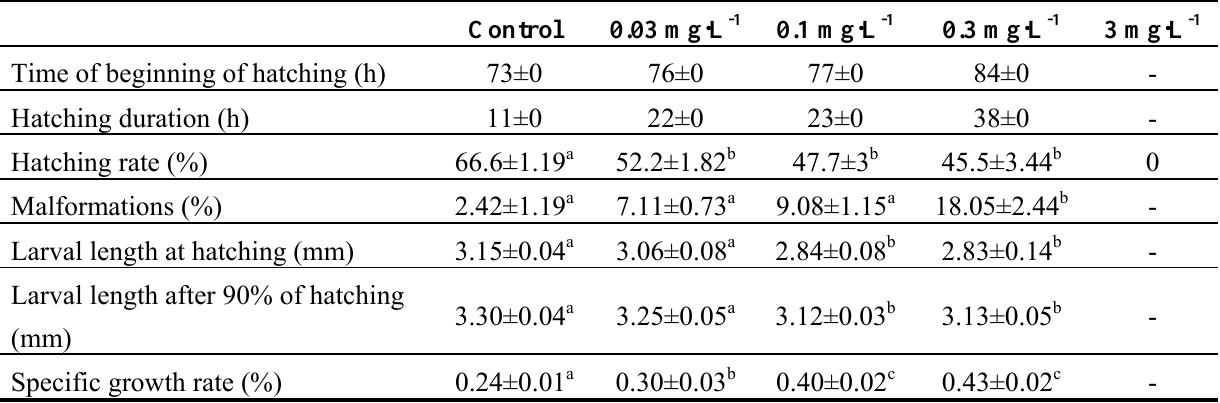
Table 1. Effect of different extracts obtained from Microcystis aeruginosa natural bloom on embryonic and larval development of the zebrafish ( Danio rerio